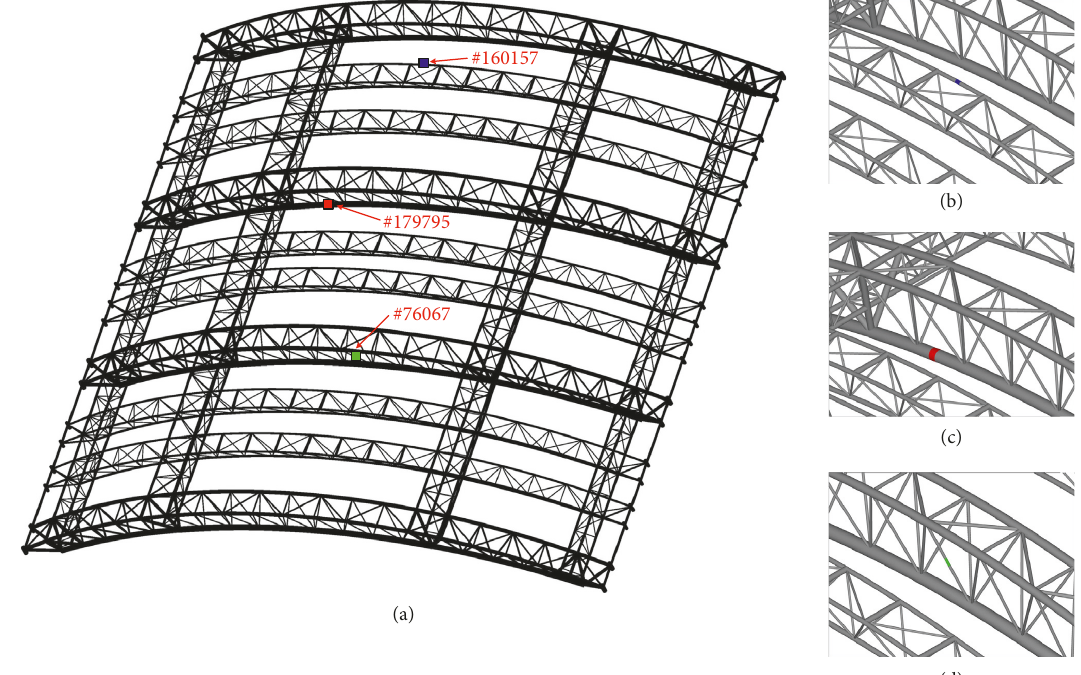
Figure 21: Layouts of element 160157, element 179795, and element 76067: (a) positions of the 3 chosen elements; (b) element 160157 (top chord); (c) element 179795(bottom chord); and (d) element 76067 (web member).